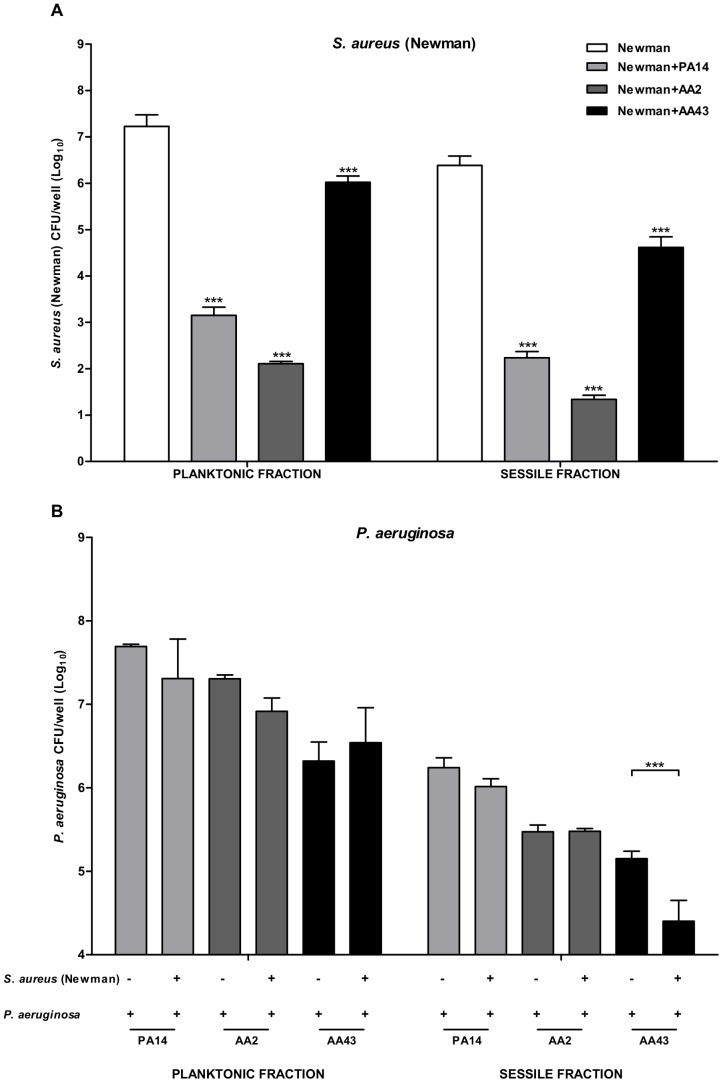

S. aureus and P. aeruginosa planktonic and sessile cells in single and dual cultures.Bacteria were grown overnight in 96-well flat-bottom microtiter plates in NB medium at 37°C either individually cultured or co-cultured at a 1∶1 ratio. CFU counts were determined in both planktonic and sessile fractions. Panel A: planktonic (left) and sessile (right) cells of S. aureus strain Newman in pure culture and in co-culture with P. aeruginosa strains PA14, AA2 and AA43. Statistically significant differences are referred to Newman in pure culture. Panel B: planktonic (left) and sessile (right) cells of P. aeruginosa strains PA14, AA2 and AA43 in pure culture and in co-culture with S. aureus strain Newman. The values represent the means of three independent experiments, and the bars indicate standard deviation. Statistically significant differences in non-parametric Mann–Whitney test are indicated by symbols when present: **: p<0.01; ***: p<0.001.